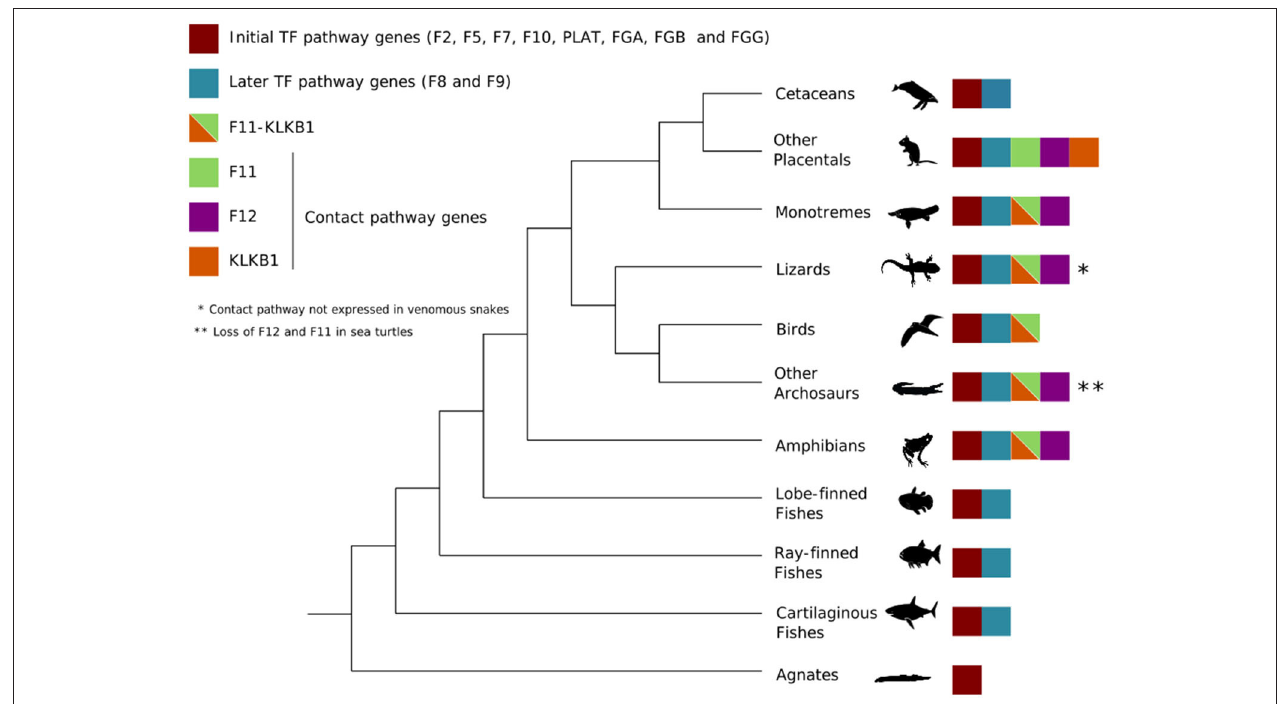
FIGURE 2 | Cladogram illustrating which genes are present in the main vertebrate groups. As indicated, contact pathway genes (F11, F12, and KLKB1) are only present in tetrapods, which are mainly land animals. TF = tissue factor pathway.